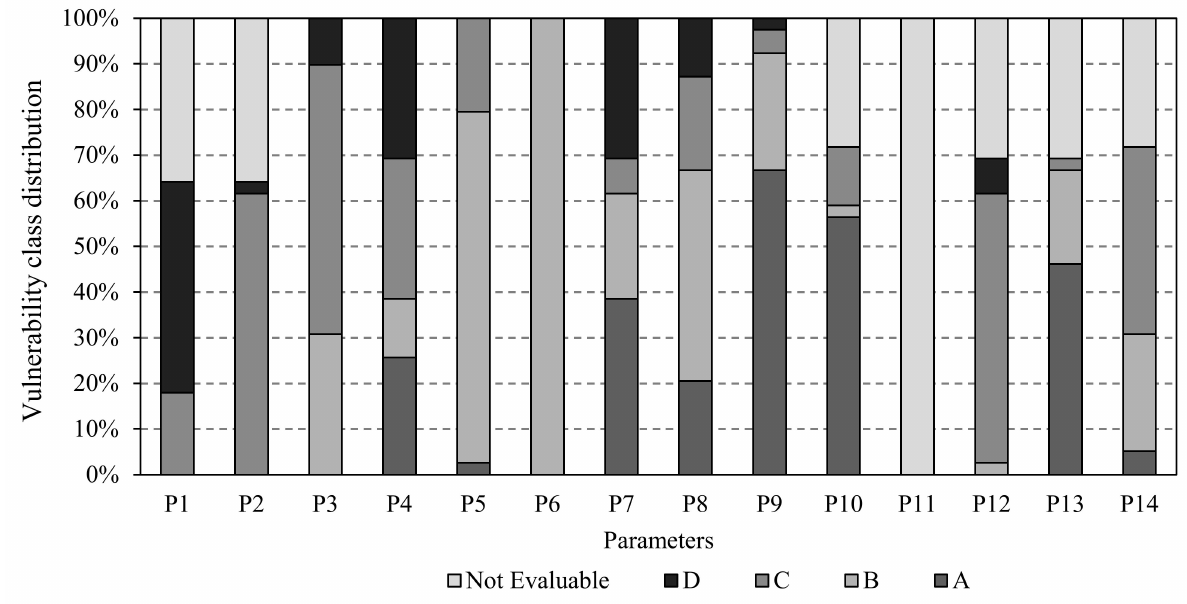
Figure 5. Vulnerability class distribution for each parameter throughout the total of